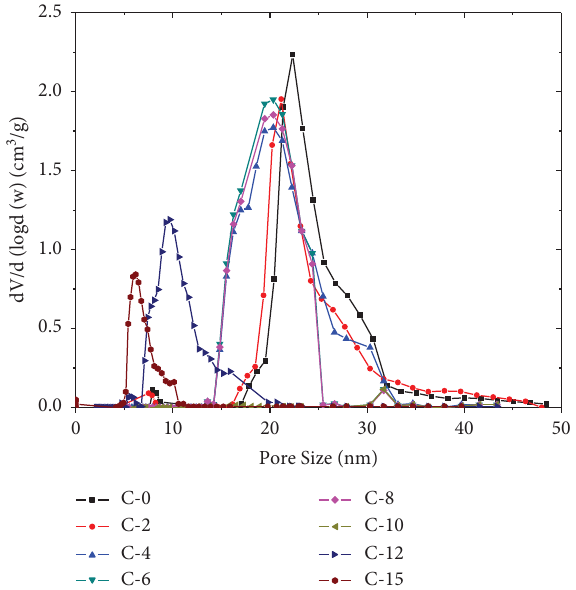
Figure 4: Pore size distribution plots.